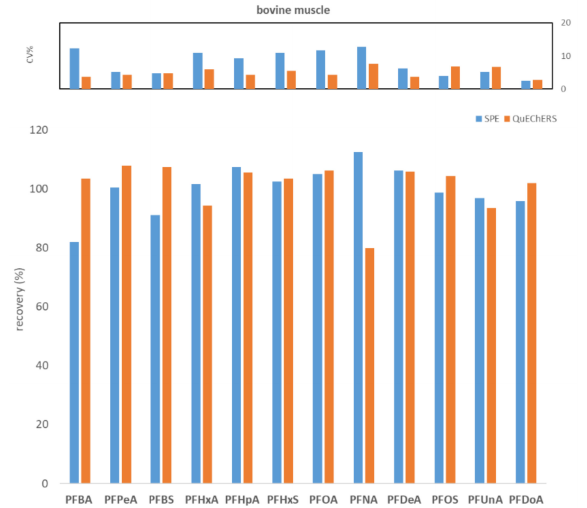
Figure 1. Comparison between SPE and QuEChERS in terms of repeatability (calculated as CV% of seven replicates at 100 ng/kg) and recovery (calculated as the average of seven replicates at 100 ng/kg) for the fish muscle matrix.